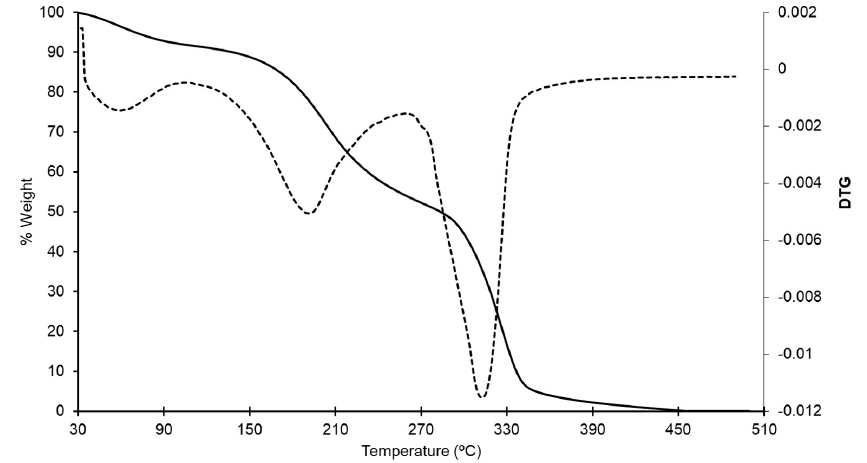
Figure 7. TGA and DTG thermograms of the starch-PEJP film.